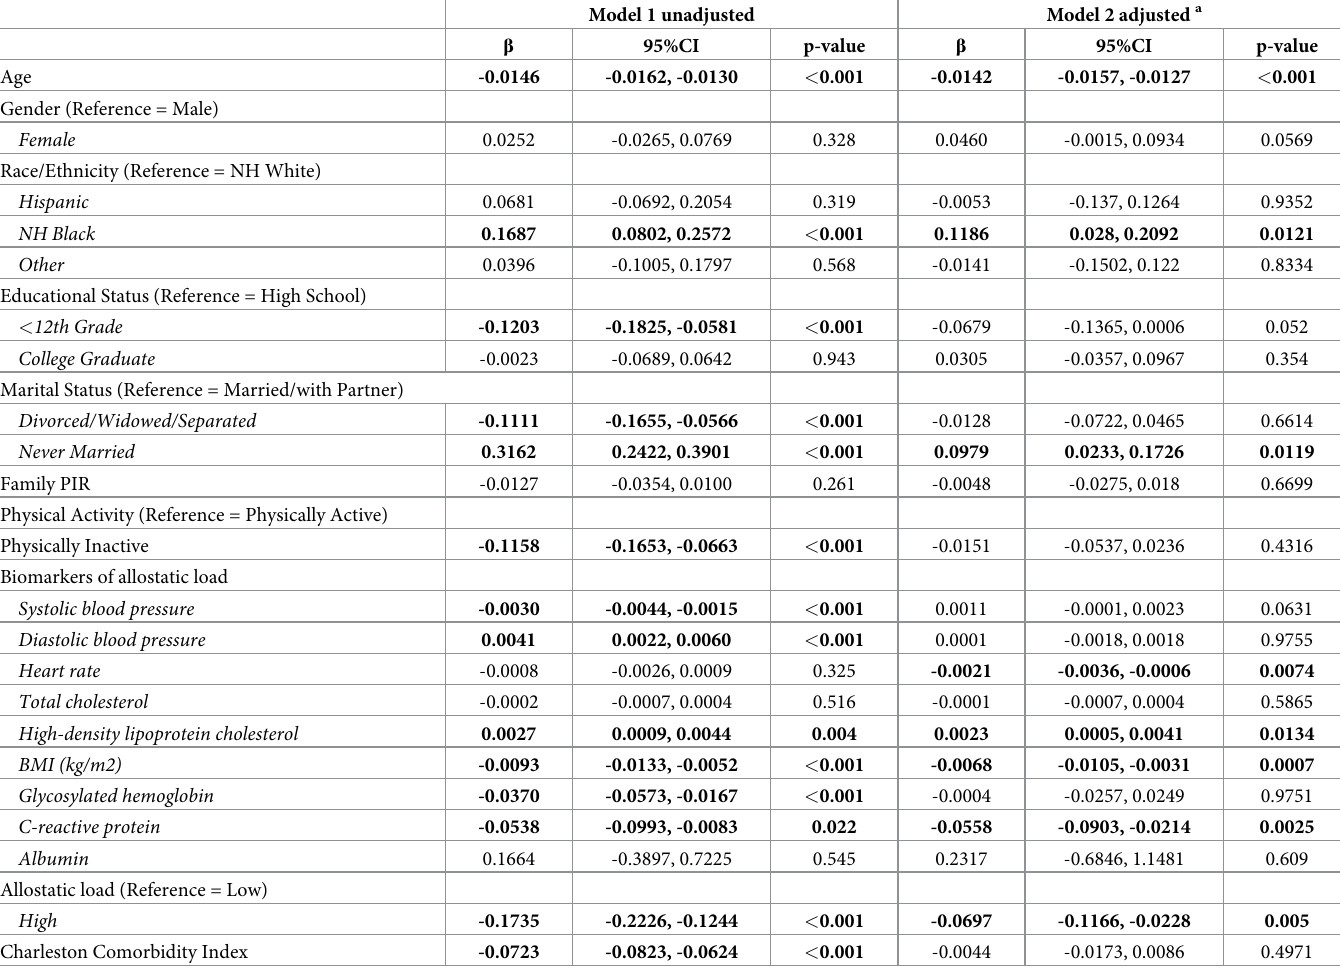
Table 2. Multivariable regression for factors associated with telomere length- NHANES